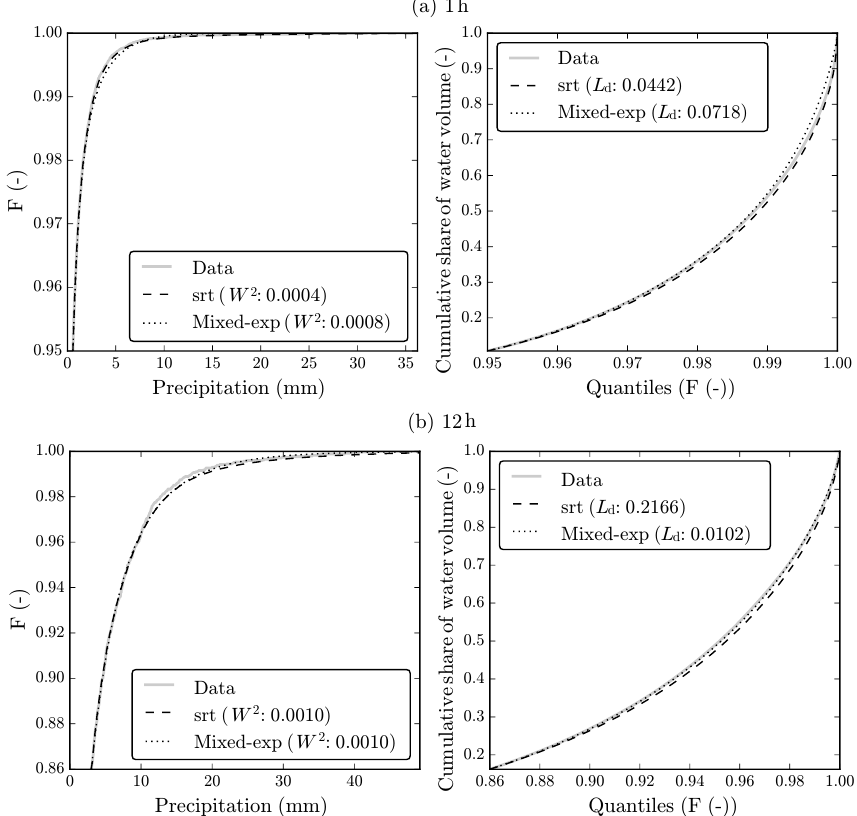
Figure 6. Empirical (data), nonparametric (SRT) and parametric (Mixed-Exp) CDF and Lorenz curve examples for the hourly (1h, a ) and 12-hourly (12h, b ) resolution of a chosen gauge. The values of the two quality measures L d and W 2 are also indicated.